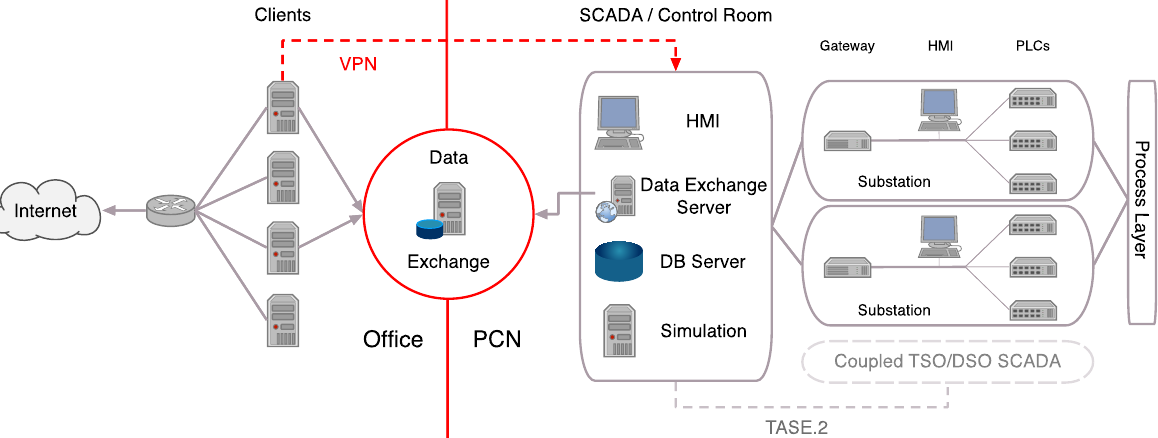
Figure 1. A simplified view of a TSO/DSO network, separated into office network (connected to the Internet, typical data processing tasks) and process control network (SCADA traffic, connecting the control room with substations and field devices). While data should only be exchanged through a dedicated data exchange server, in reality, these networks are often interconnected, e.g., with